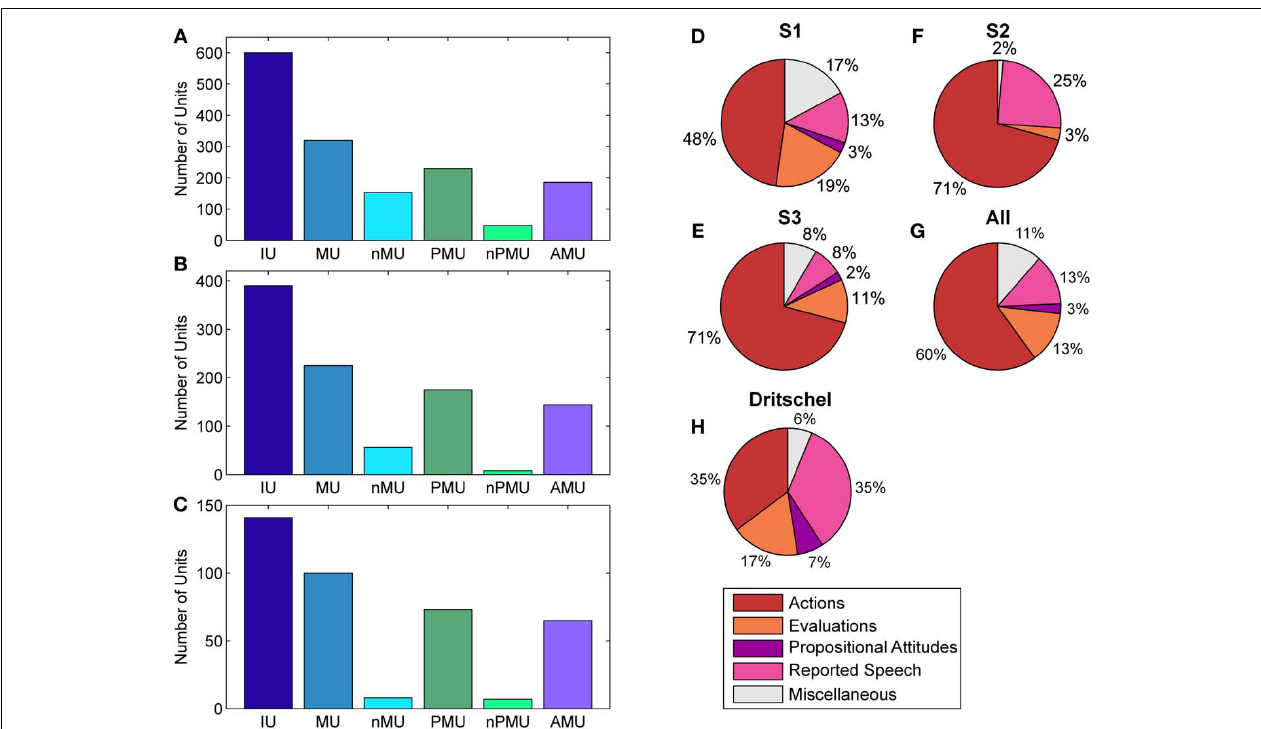
FIGURE 2 | Distributions of IUs across categories and subjects. Panels (A–C) show distributions for categories which entered ECoG data analysis for S1–S3, respectively. Panels (D–F) show the fractions of “actions,” “evaluations,” “propositional attitudes,” and “reported speech” in the superordinate AMU category. (G) Summarizes the results in (D–G) as a